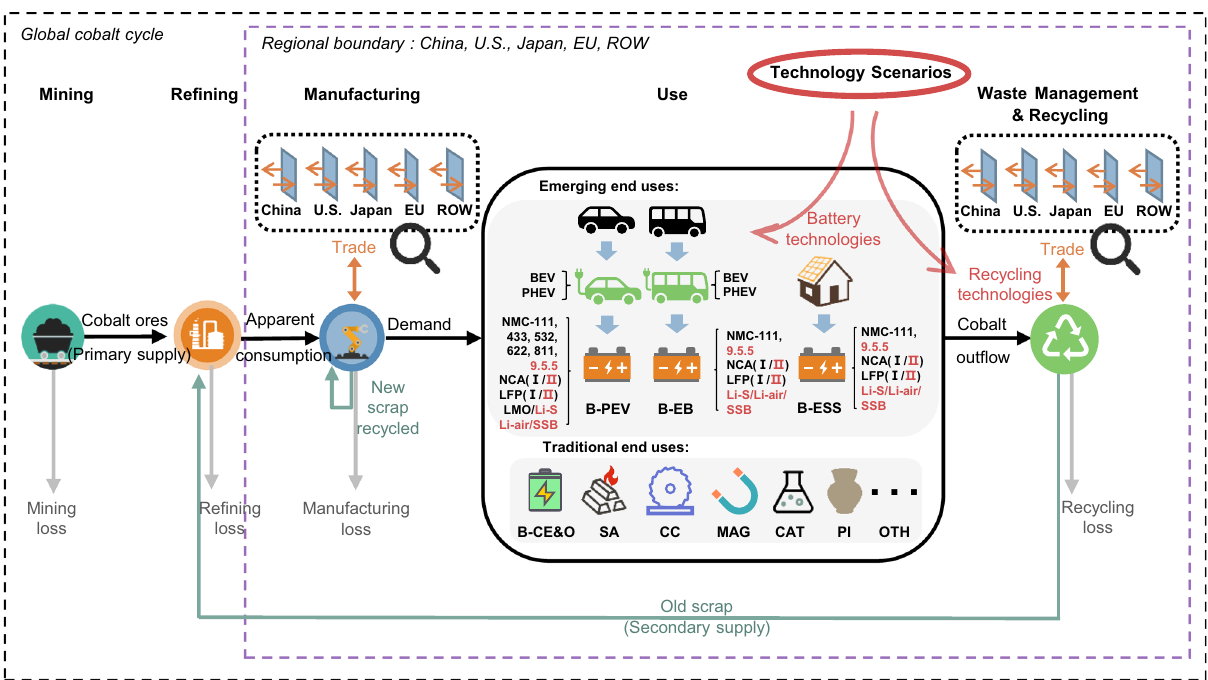
Fig. 1 System de fi nition of the global anthropogenic cobalt cycle and modeling framework for cobalt demand and secondary supply potentials. BEV battery electric vehicles, PHEV plug-in hybrid electric vehicles, NMC lithium nickel manganese cobalt oxide, NCA(I) lithium nickel cobalt aluminum oxide, NCA(II) advanced NCA with lower cobalt content and higher energy density, LFP(I) lithium iron phosphate, LFP(II) new form of LFP (e.g., blade LFP battery developed by the company BYD), LMO lithium manganese oxide, Li-air lithium-air, Li-S lithium-sulfur, SSB solid-state battery, B-PEV battery for electric passenger vehicles, B-EB battery for electric buses, B-ESS battery for energy storage systems, B-CE&O battery for consumer electronics and other battery products, SA superalloy, CC cemented carbides, MAG magnets, CAT catalysts, PI pigments, OTH other end uses. Battery cathodes in black and red colors indicate state-of-the-art battery technologies and future battery technologies,